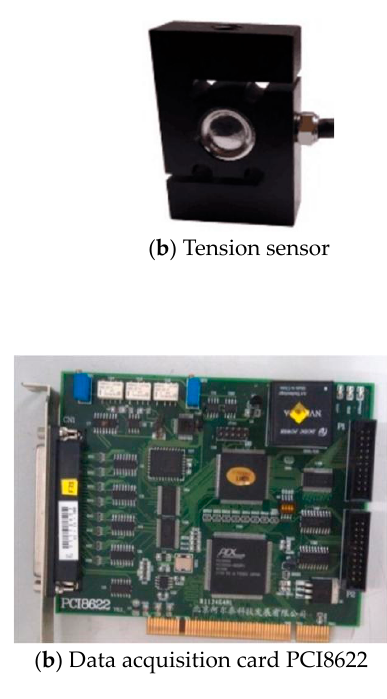
Figure 12. A data ‐ processing software programmed by the authors. 4. Results and Discussion 4.1. Theoretical Verification In Section 4.1, SRBs ʹ dynamic characteristics are simulated and compared with the published results under the non ‐ self ‐ aligning operating condition, which will verify the correctness and rationality of the model proposed in this paper. SRBs ʹ material and geo ‐ metrical parameters are listed in Table 1, and the global coordinate is referred to in Figure 2. The external loads in the X, Y, and Z directions are 12 kN, 18 kN, and 0.15 kN, respec ‐ tively. And a random load ranging from 1~50 N is also existed. In addition, the rotor speed is 1200 rpm. A set of SRBs ʹ fundamental geometrical and material parameters are listed in Table 1. It should be noted that some parameters may not be the same with different SRB brands.